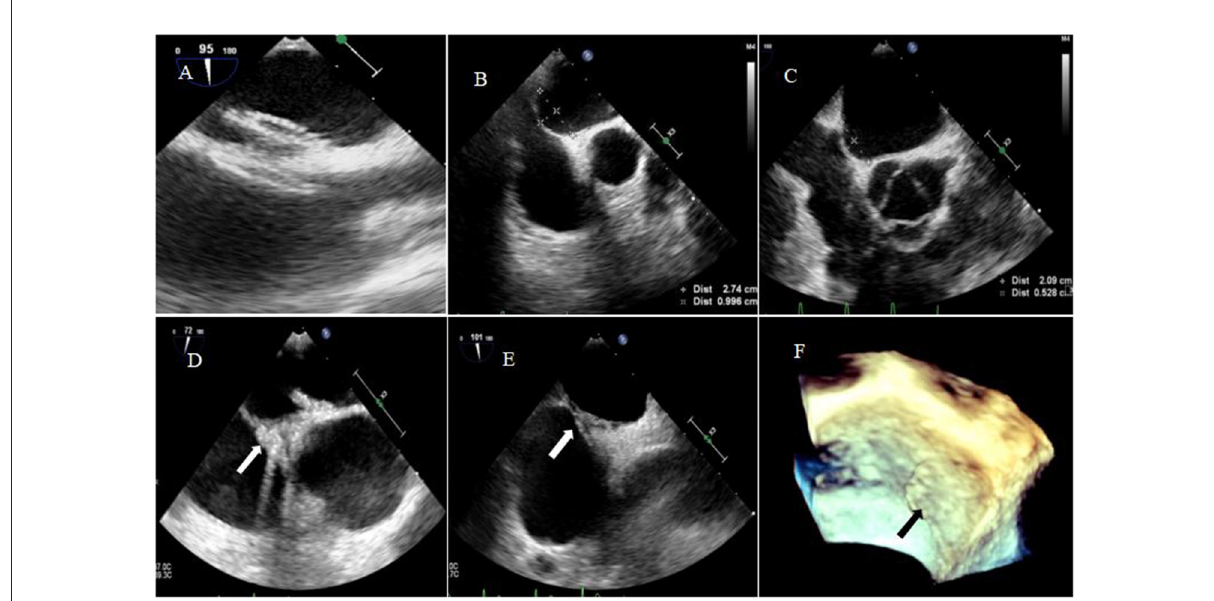
FIGURE5 Change in ASA before and 12 months after occlusion; 2D-TEE showing the occluder during occlusion and 3D showing the occluder 12 months after occlusion. (A) TEE showing a grid-like structure of the occluder during occlusion; (B) 2D-TEE demonstrating ASA size before occlusion; (C) 2D-TEE showing the size of ASA reduced in the same patient; (D) 2D-TEE showing the long tunnel occluder; (E) 2D-TEE showing double umbrella disc occluder; (F) 3D-TEE showing complete endothelialization of the umbrella surface.